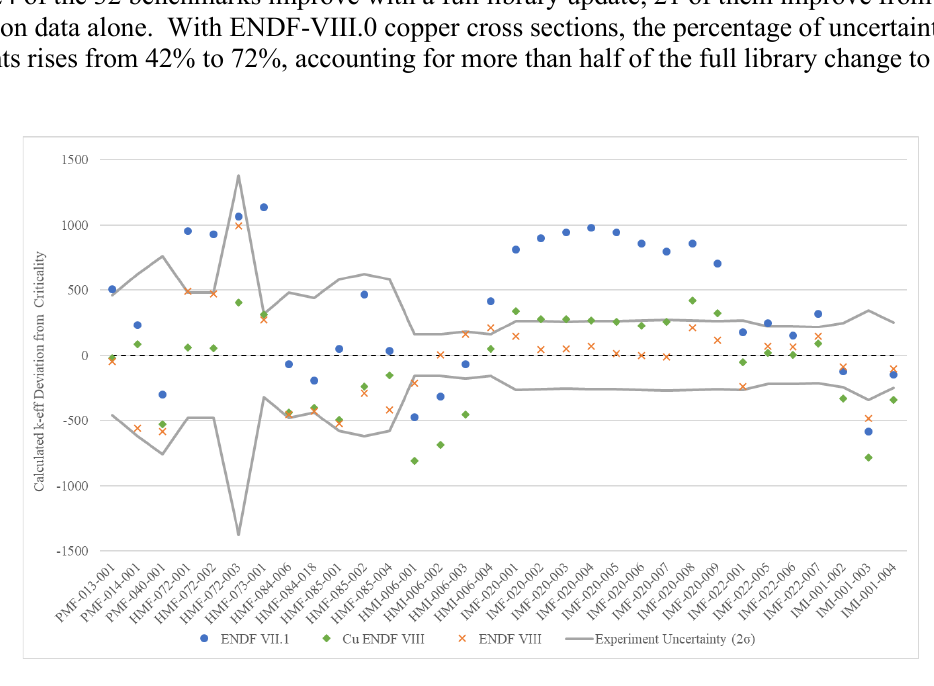
Figure 2. Result of ENDF-VIII.0 Copper Cross Section